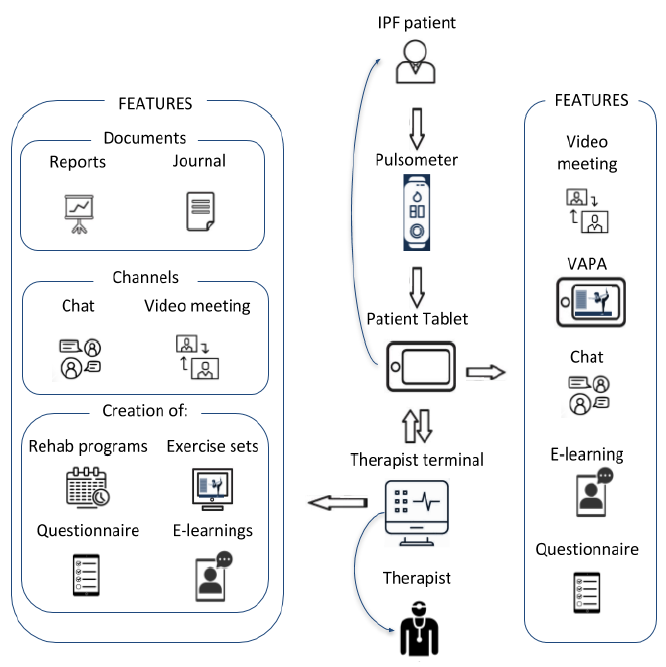
Figure 1. Digital ecosystem of the multidimensional VAPA platform.